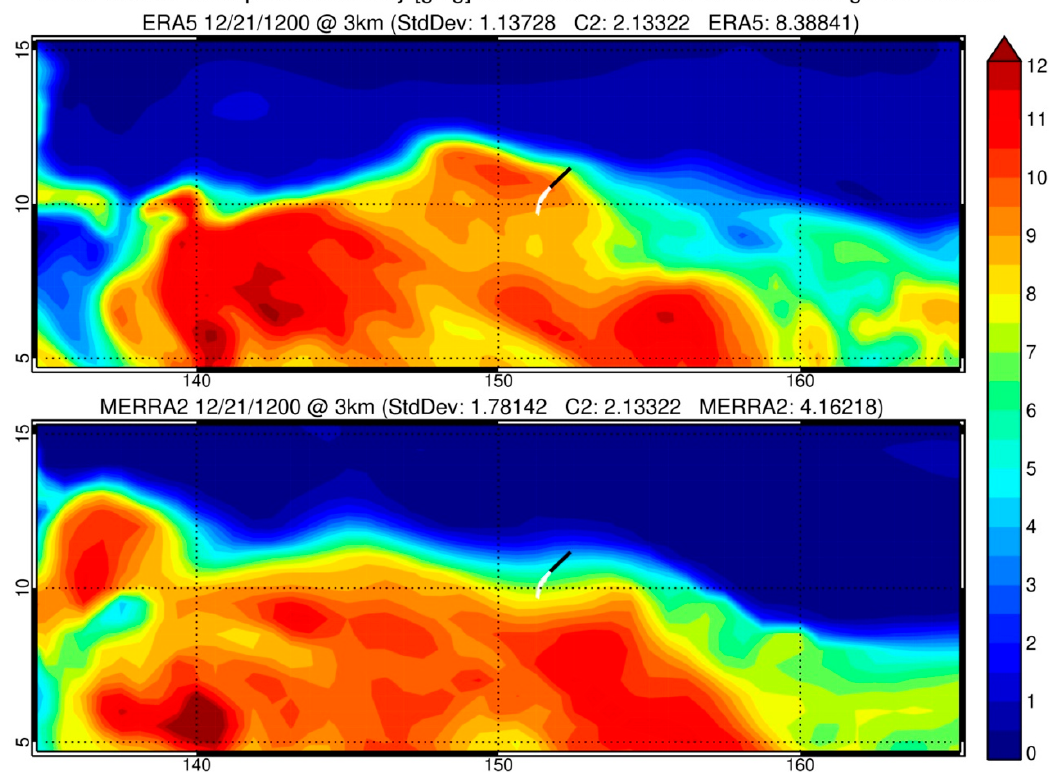
Figure 8. ( Top ) ERA5 regional specific humidity at 3 km and ( Bottom ) MERRA-2 regional specific humidity at 3 km on 21 December 2019 at 12:00 UTC, with a large moisture gradient present and large specific humidity differences relative to the collocated C2 profile. The collocated C2 profile tangent points are indicated by the solid white and black line, with the black line indicating tangent points below 5 km.